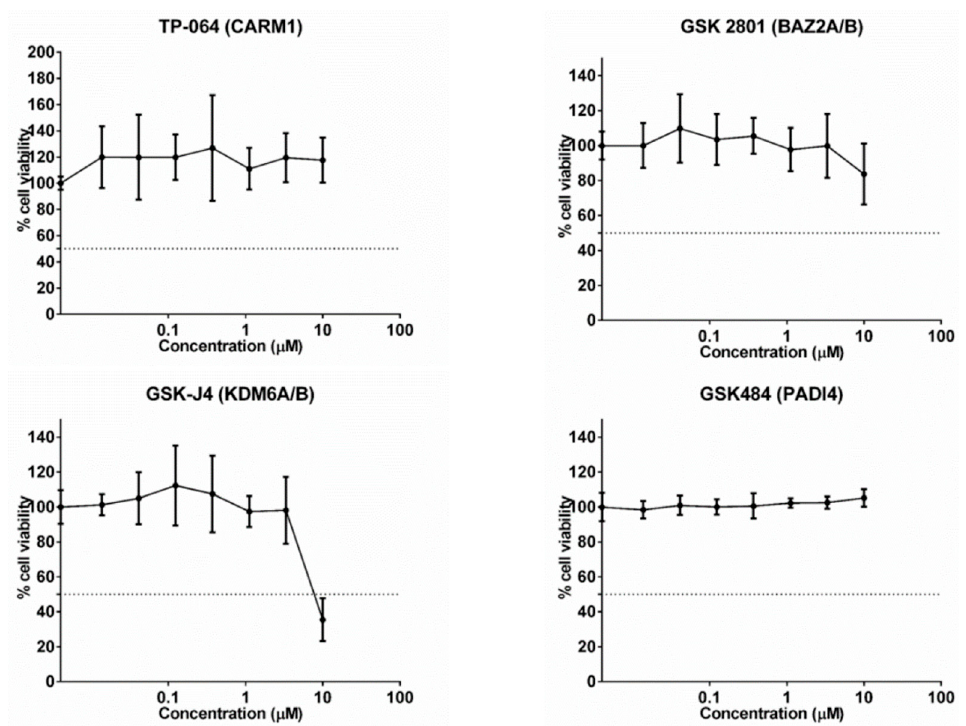
Figure 1. Cytotoxic potential of the 4 specific epigenetic molecules in the A549 cell line. The GSK-J4 (KDM6A/B) molecule had an IC 50 value of 8.21 µM, the others had a value greater than 10 µm. Inhibition of the epigenetic targets KDM6A/B and PADI4 reduced cell invasiveness compared to the control group ( p < 0.05) in the A549 and H1568 cell lines (Figure 2).